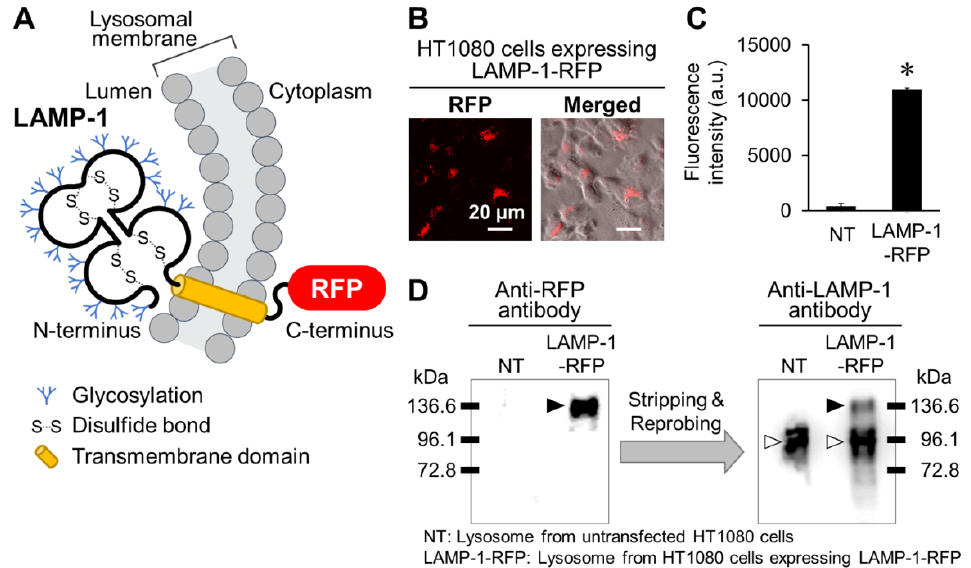
Figure 2. Construction of lysosomes expressing LAMP-1-RFP in human fibrosarcoma HT1080 cells. ( A ) Schematic representation of LAMP-1-RFP in the lysosomal membrane. ( B ) HT1080 cells expressing LAMP-1-RFP were established by transfection of a LAMP-1-RFP expression plasmid. Red fluorescence indicates LAMP-1-RFP. ( C ) Lysosomes were extracted from untransfected and transfected HT1080 cells. The extracted lysosomes were captured, and their red fluorescence intensity was measured with a multiplate reader. ( D ) The extracted lysosomes were analyzed by Western blotting using anti-RFP and anti-LAMP-1 antibodies. Each PVDF membrane was initially probed with the anti-RFP antibody and then stripped and reprobed with the anti-LAMP-1 antibody. The black and white arrowheads indicate LAMP-1-RFP and native LAMP-1, respectively.